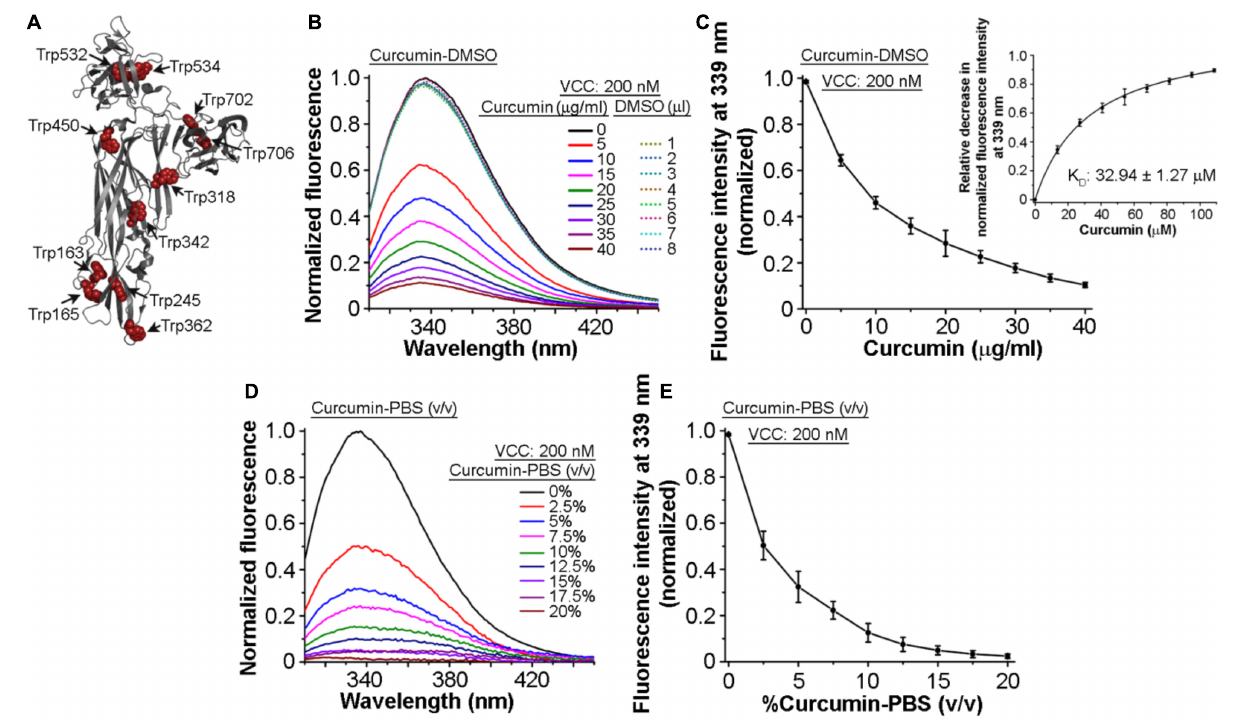
FIGURE 2 | Intrinsic tryptophan fluorescence of VCC gets quenched in the presence of curcumin. (A) Structural model of VCC showing the distribution of the tryptophan residues throughout the protein structure. (B,C) Intrinsic tryptophan fluorescence emission profile of VCC upon treatment with curcumin from a stock solution prepared in DMSO (curcumin-DMSO). Equivalent volumes of DMSO without curcumin did not affect the tryptophan fluorescence emission profile of VCC (shown with the dotted curves in B ). Non-linear fitting of the fluorescence data (relative decrease in the tryptophan fluorescence at 339 nm) against the varying concentration of curcumin revealed the K D value of the VCC-curcumin interaction in the range of ∼ 32.94 µ M (inset in C ). (D,E) Intrinsic tryptophan fluorescence emission profile of VCC in the presence of the curcumin extract in PBS (curcumin-PBS). Data shown in (B,D) are the representatives of four independent experiments. Data shown in (C,E) are the averages ± standard deviations of four independent experiments. Concentrations of VCC and curcumin shown here represent the final amount present in the reaction